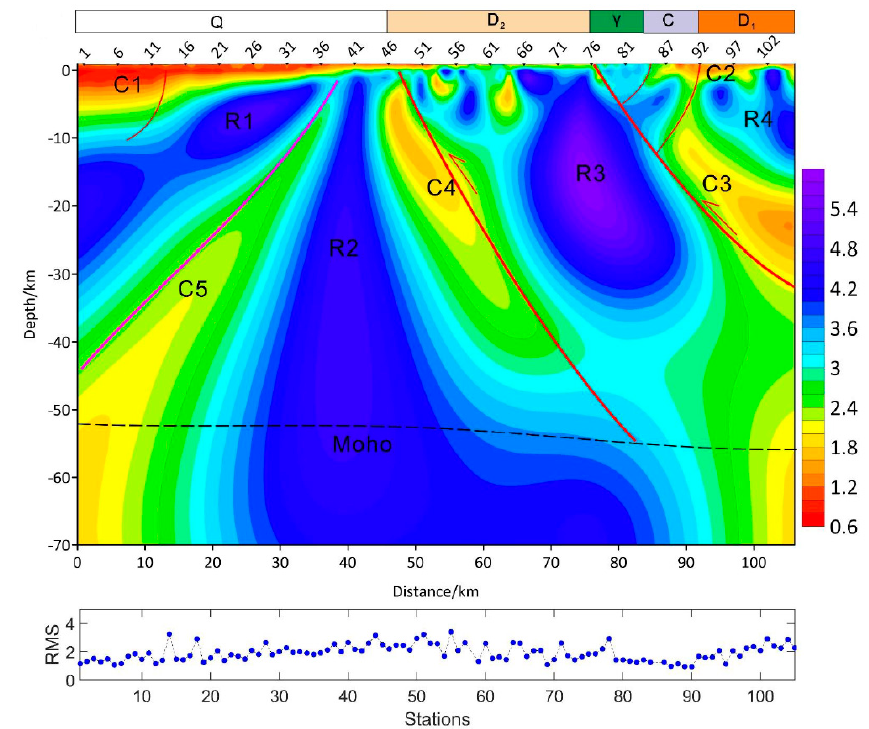
Figure 7. Two-dimensional resistivity model and the RMS of every MT point.